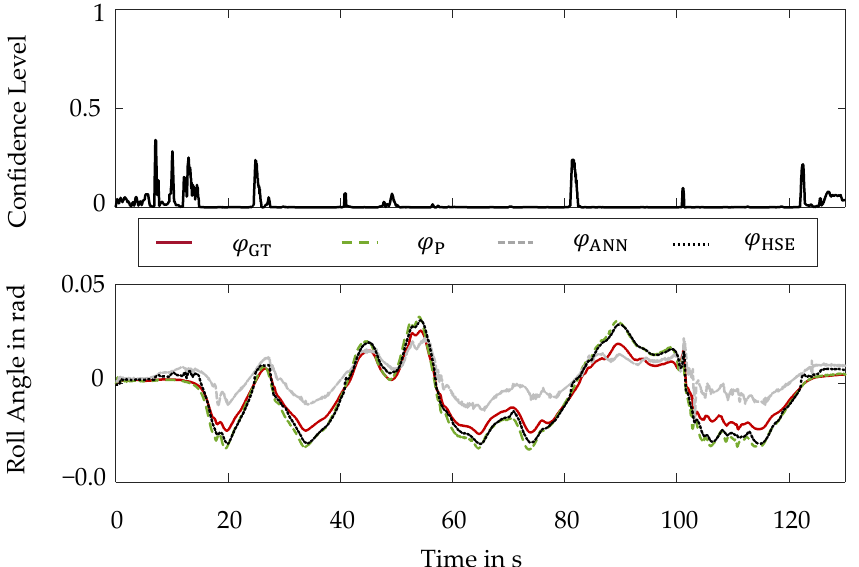
Figure 7. Hybrid Method of State Estimation-Hockenheimring Racetrack: ( Top ): Confidence Level; ( Bottom ): Roll Angle Curves.